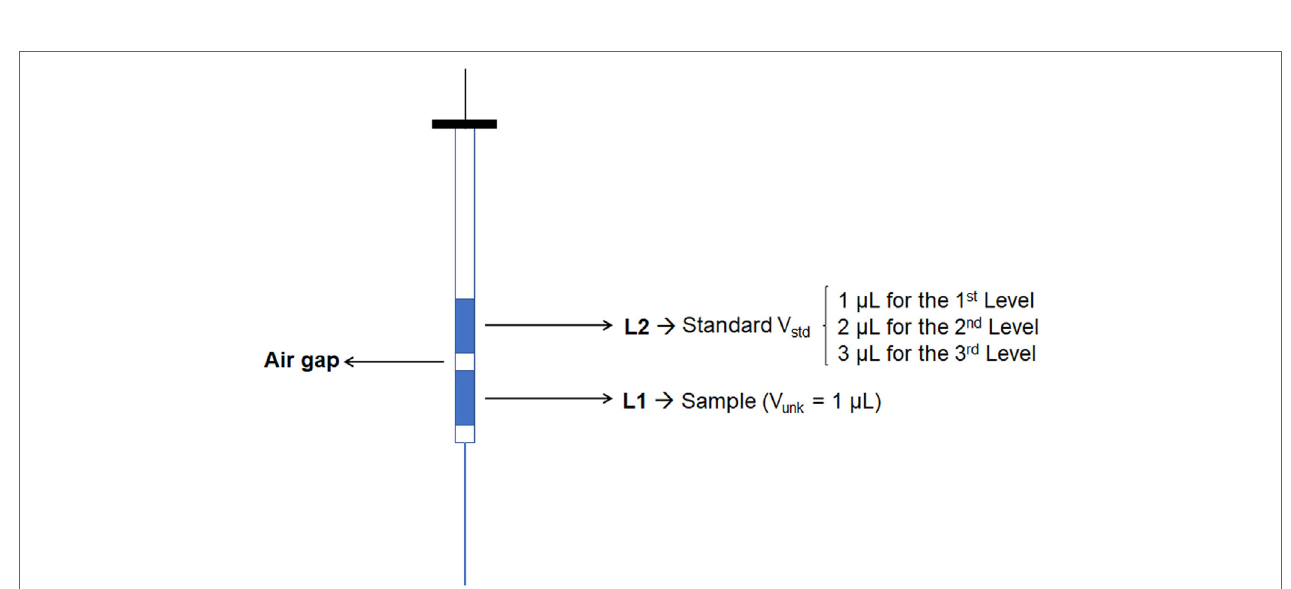
FigUre 2 | Sandwich injection scheme.